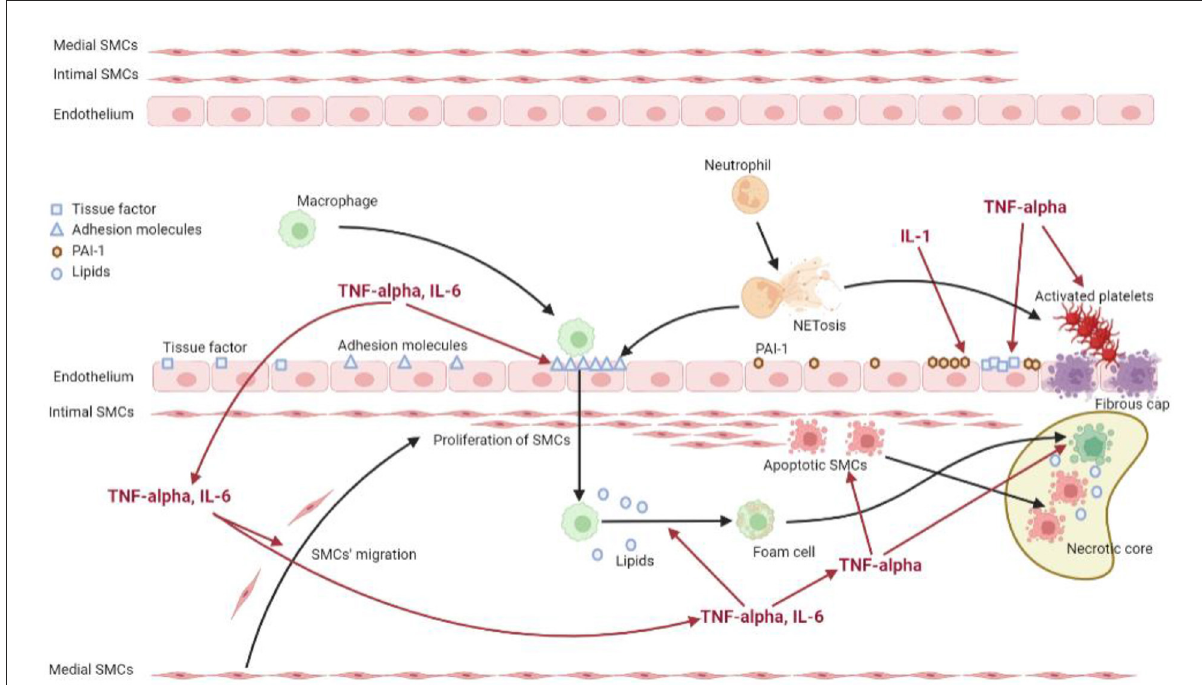
FIGURE1 Mechanisms of inflammation promoting the atherosclerotic process in rheumatoid arthritis. The figure shows the interplay between inflammation and the different effectors of the atherosclerotic process. The systemic inflammation, supported by pro-inflammatory cytokines such as TNF-alpha, IL-6 and IL-1, acts on the endothelial cells inducing the expression of adhesion molecules, tissue factor and PAI-1. It also promotes the migration of smooth muscle cells from the media to the intima, as well as facilitates the uptake of lipids by the macrophages. Moreover, the inflammatory state acts on platelets and neutrophils, triggering the process of NETosis, which stimulates on one hand the expression of adhesion molecules by endothelial cells, on the other hand the activation of platelets contributing to a prothrombotic